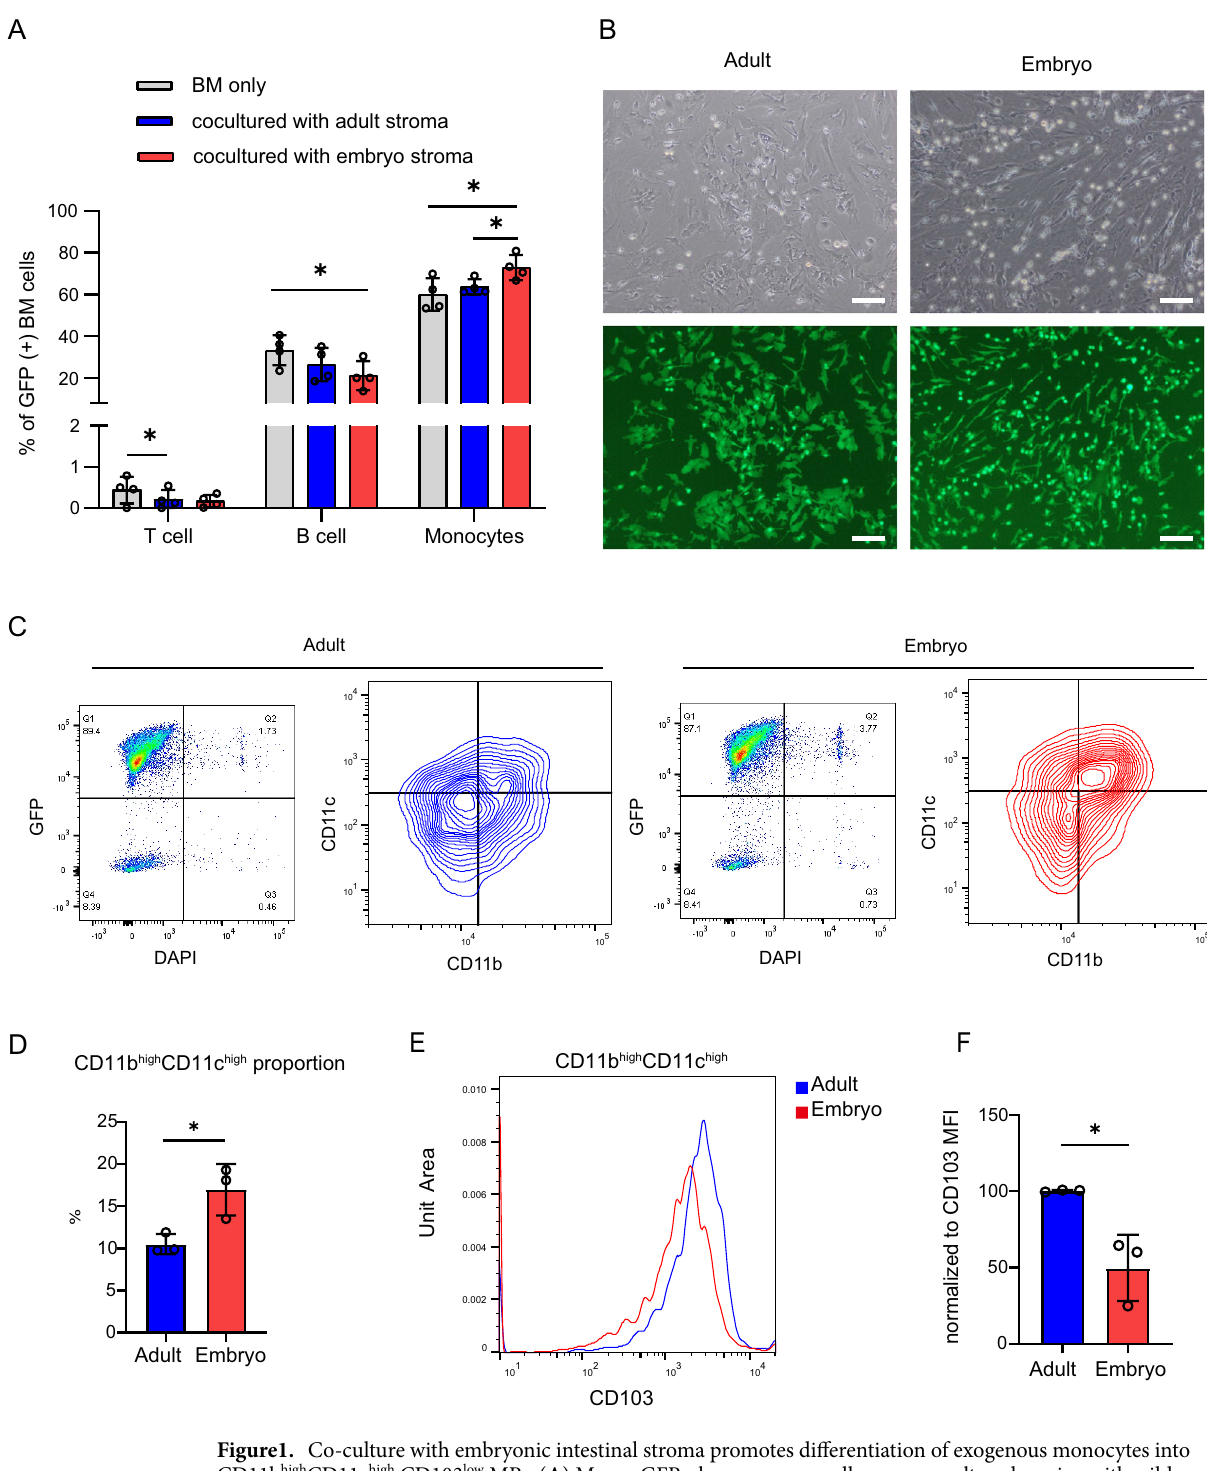
Figure1. Co-culture with embryonic intestinal stroma promotes differentiation of exogenous monocytes into CD11b high CD11c high CD103 low MPs. ( A ) Mouse GFP + bone marrow cells were co-cultured ex vivo with wild type adult or embryonic intestinal stroma for 2 days. The differentiation state of live GFP + cells was analyzed by flow cytometry. T cells; CD3 + , B cells; B220 + , myelomonocytic cells; CD3 - B220 - CD11b + n = 4 biological replicates. One way ANOVA with Tukey’s multiple test. *p < 0.05. ( B ) Representative bright field and fluorescent images of GFP labelled monocyte derived cells co-cultured with wild type intestinal adult or embryonic stromal cells for 2 days. Scale bar = 100 µm. ( C ) DAPI - GFP + live monocyte derived cells from ex vivo coculture of stromal cells and monocytes shown in ( B ), were analyzed for CD11b and CD11c expression by flow cytometry. ( D ) Quantification of ( C ) showing the percentage of CD11b high CD11c high cells. n = 3 biological replicates. t-test. *p < 0.05. ( E ) Histogram showing CD103 expression in CD11b high CD11c high gated cells from ( C ). ( F ) CD103 MFI in CD11b high CD11c high gated cells from ( C ) normalized to adult stroma. n = 3 biological replicates. t-test. *p <